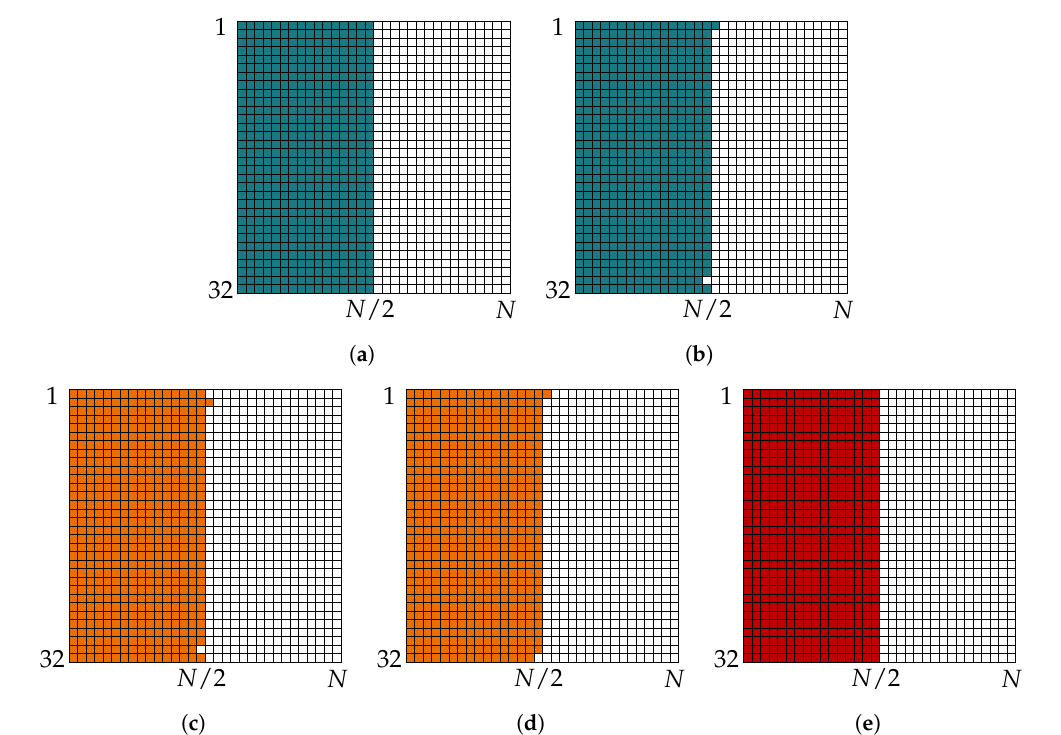
Figure 13. Frozen charts for half-rate polar code with N = 1024 and design E b / N 0 = 3 dB, constructed using ( a ) Tal and Vardy’s method with |T | = 512, ( b ) Tal and Vardy’s method with |T | = 16, ( c ) information bottleneck method with |T | = 16, ( d ) information bottleneck method with |T | = 32, and ( e ) Gaussian